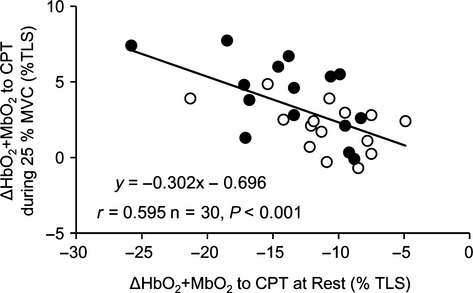
Relationship the changes in HbO2 + MbO2 in response to acute sympathetic stimulation with CPT between at rest and during moderate-intensity handgrip exercise (25% MVC). White circles represent CON and black circles represent IPC condition.